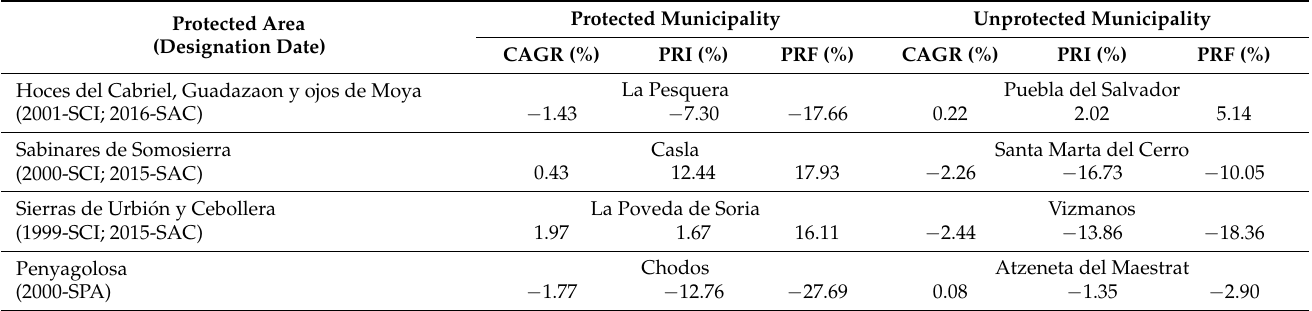
Table 1. Selected pairs of Spanish rural municipalities with the most contrasting depopulation figures before and after each protected area was designated in the 1996 – 2019 period. CAGR: Compound Annual Growth Rate; PRI: Proportion of reproductive individuals; PRF: Proportion of reproductive females. SCI: Site of Community Importance; SAC: Special Areas of Conservation; SPA: Special Protection Area.